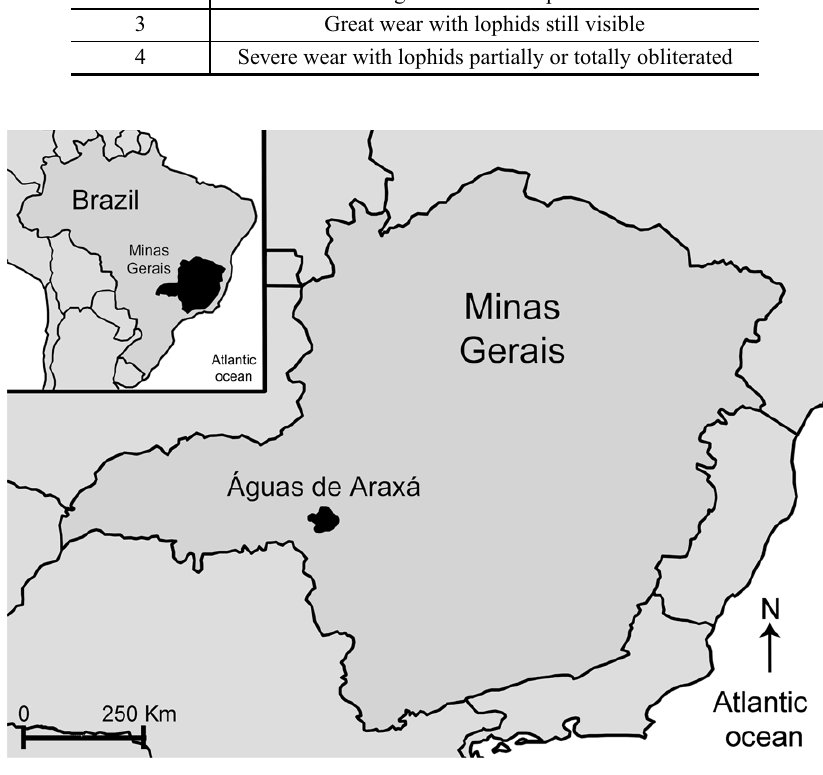
Fig. 1 – Location of Minas Gerais State. Águas de Araxá locality is represented on the largest map by the darkened